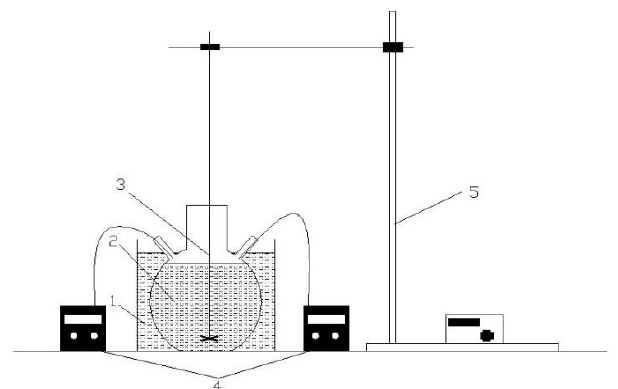
Figure 1. Schematic diagram of experimental device for preparing calcined fly ash coated with magnesium hydroxide (CFAMH) and magnesium hydroxide (MH). 1: Water bath, 2: CFA suspension, 3: Rotor, 4: Constant flow pump, 5: Iron support.